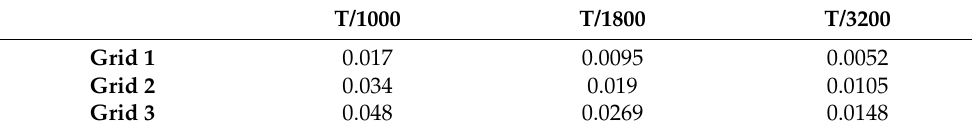
Table 2. Courant number for every combination of the mesh convergence study.